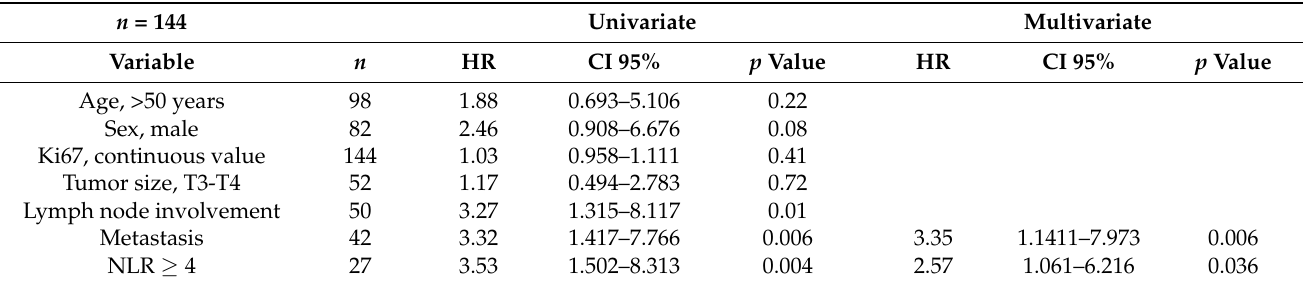
Table 2. Univariate and multivariate analysis of variables for overall survival